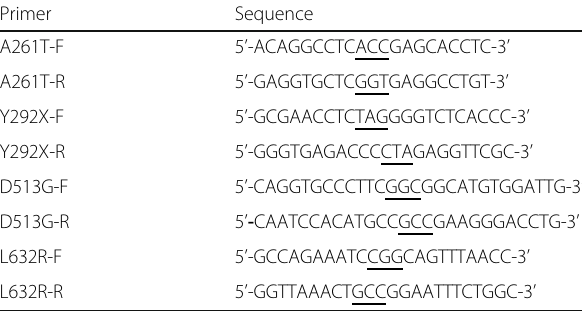
Table 1 Oligonucleotide primers used for site-directed mutagenesis in generation of GAA